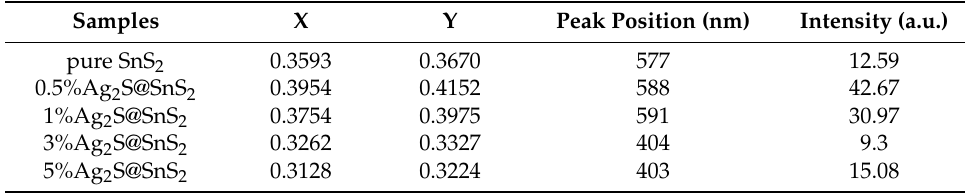
Table 1. The coordinates (x, y) corresponding to the CIE chromaticity diagram of pure SnS 2 and Ag 2 S@SnS 2 composites.